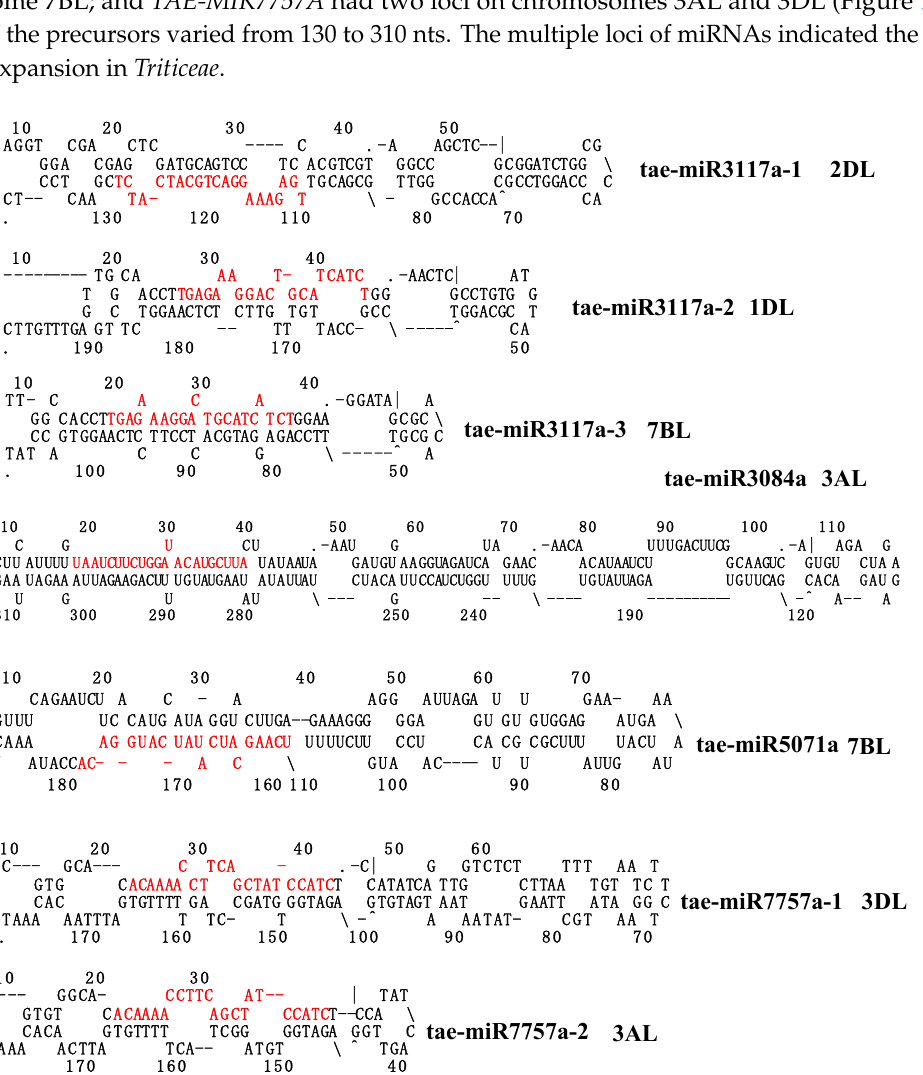
Figure 1. The precursors of TAE-MIR3117a , TAE-MIR3084a , TAE-MIR5071a , and TAE-MIR7757a disease resistance-associated miRNAs. The red letters represent the mature miRNA sequences.